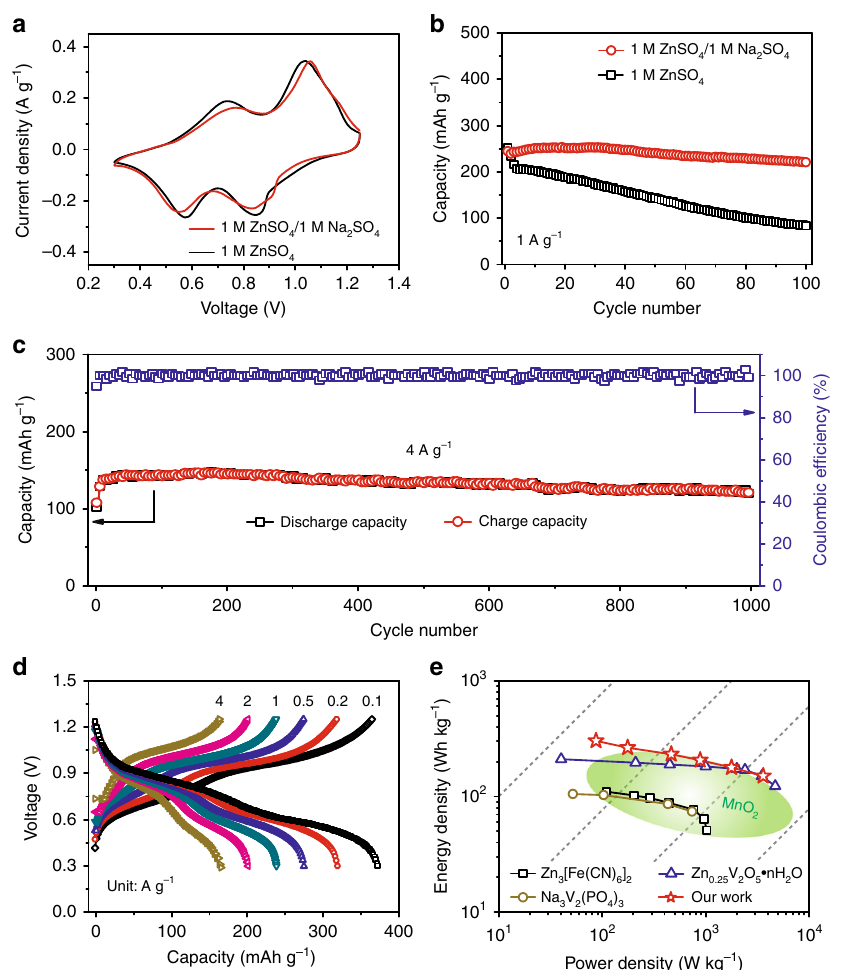
Fig. 3 Electrochemical performance of Zn/NVO batteries in 1 M ZnSO 4 electrolyte with 1 M Na 2 SO 4 additive. Comparison of a second CV curves (0.1 mV s – 1 ) and b cycling performance (1 A g – 1 ) of NVO electrodes in ZnSO 4 and ZnSO 4 /Na 2 SO 4 electrolytes. c Long-term cycle life (4 A g – 1 ) and d rate performance of NVO electrodes in ZnSO 4 /Na 2 SO 4 electrolyte. e Comparison of energy and power densities of Zn/NVO battery with ZIBs based on reported positive